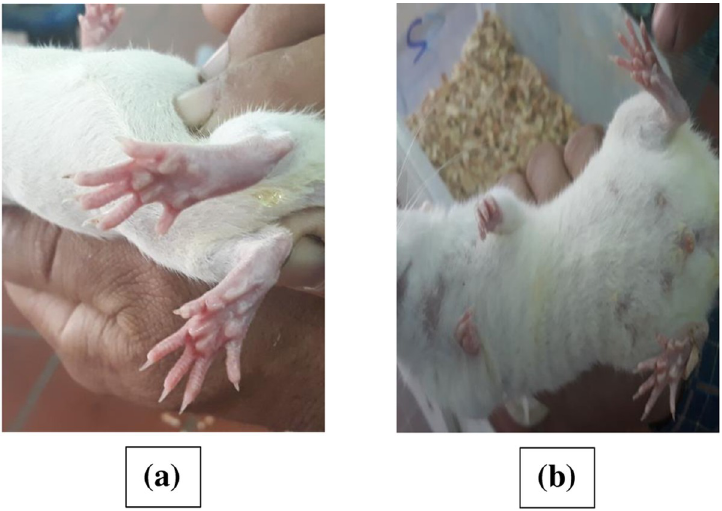
Fig 6. Images of right hind paw of rats showing edema before (a) and 0.5 hr after administration of optimized DCN-ODT